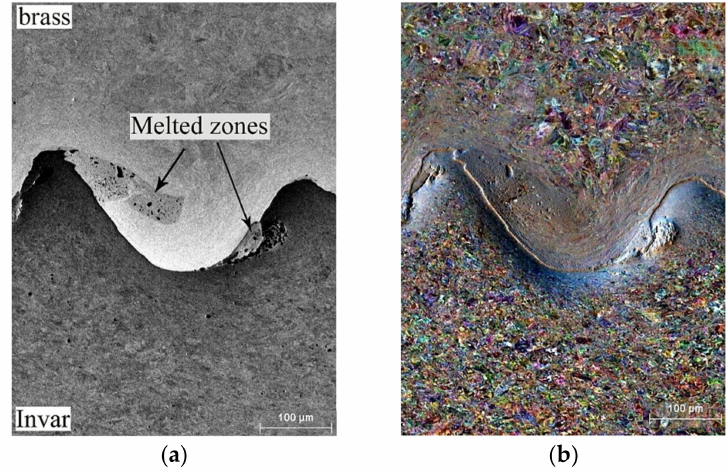
Figure 3. BSE ( a ) and FSD ( b ) images of the weld